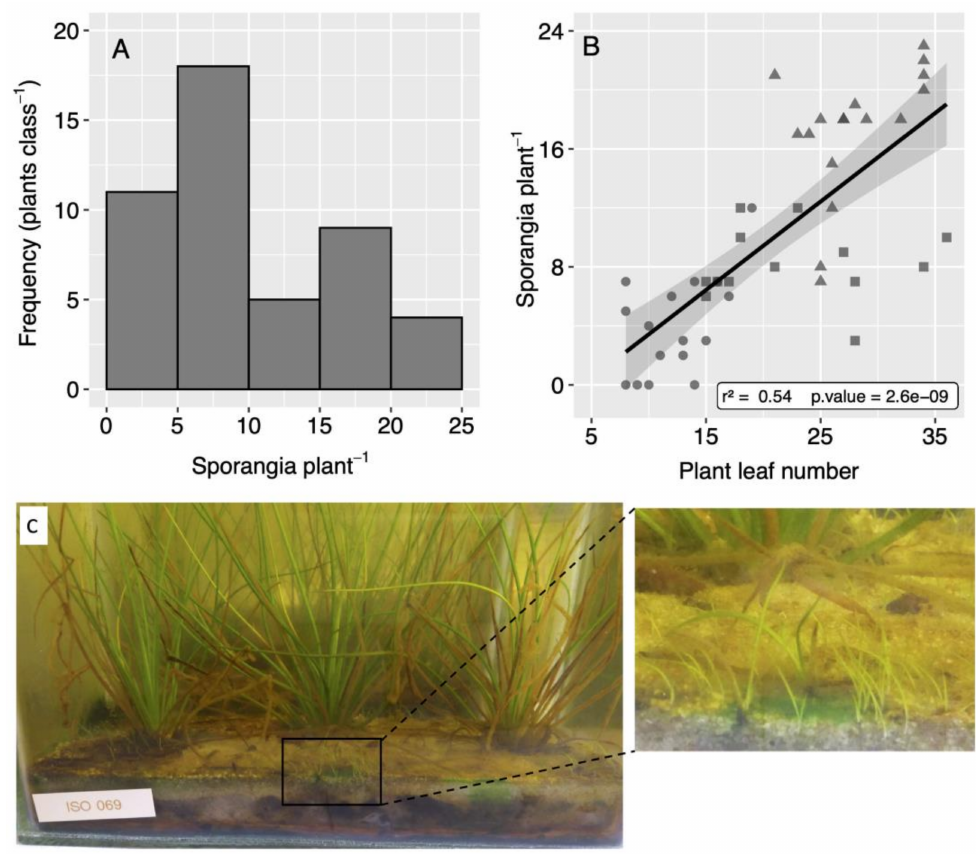
Figure 5. Sporangia and sporophyte production for Isoëtes cangae plants growing in controlled environmental conditions. ( A ) Classes of sporangia produced by 12-month-old plants of I. cangae , ( B ) a linear relationship between sporangia and plant leaf number (y = 0.615x − 3.093), and ( C ) plants of I. cangae 24 months old with several young sporophytes growing close to the mother plants. In ( B ), each symbol represents one plant cultivated in commercial substrate Jiffy-7 ® (circles), a mixture of Jiffy-7 ® and lake sediment (squares), and lake sediment